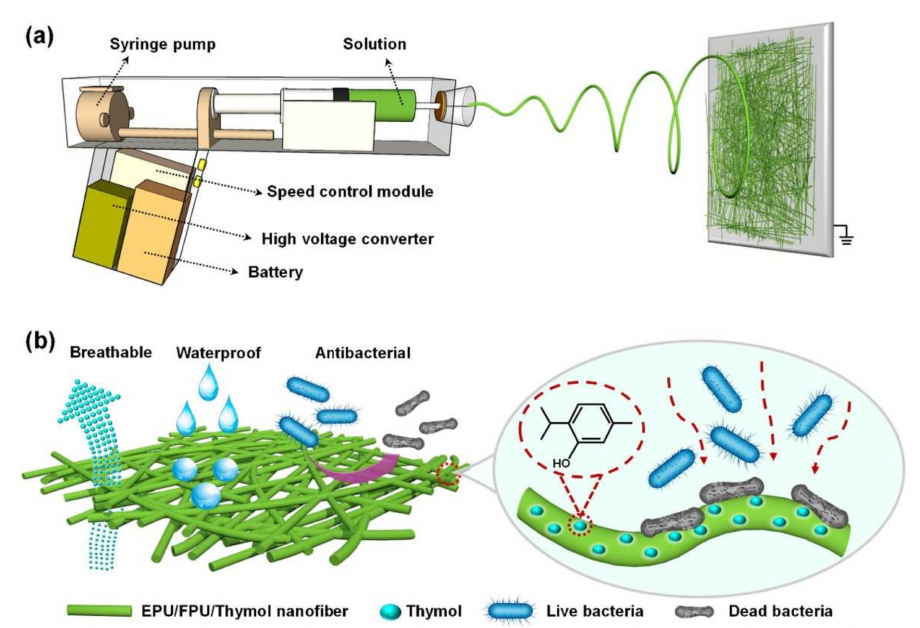
Figure 10. ( a ) Fabrication of EPU/FPU/Thymol nanofibrous membranes using the ES portable device. ( b ) Demonstrative scheme of the breathable, waterproof and antibacterial action of EPU/FPU/Thymol nanofibers. Republished under the permission of Yue et al.